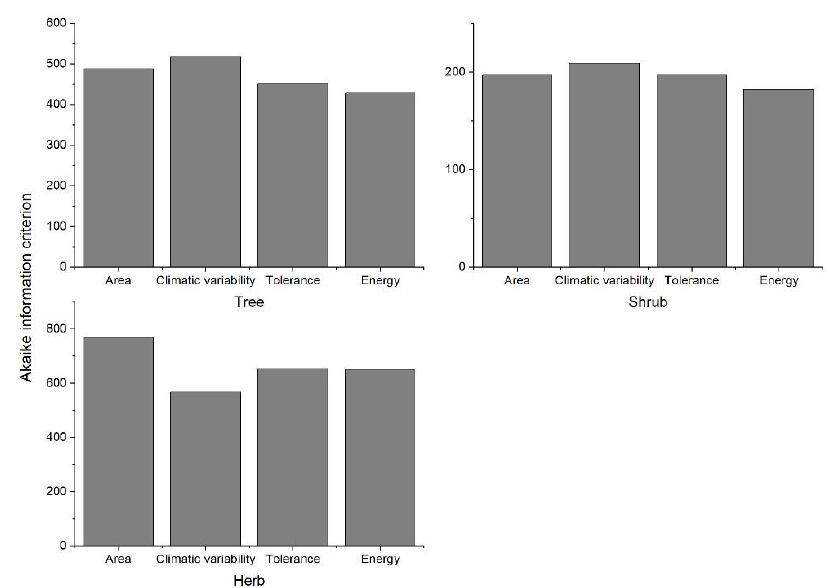
Figure 3. The Akaike information criterion (AIC) for different hypothesis in predicting elevational species richness patterns of each plant growth form group, the average value of AIC of each hypothesis related factor is given.